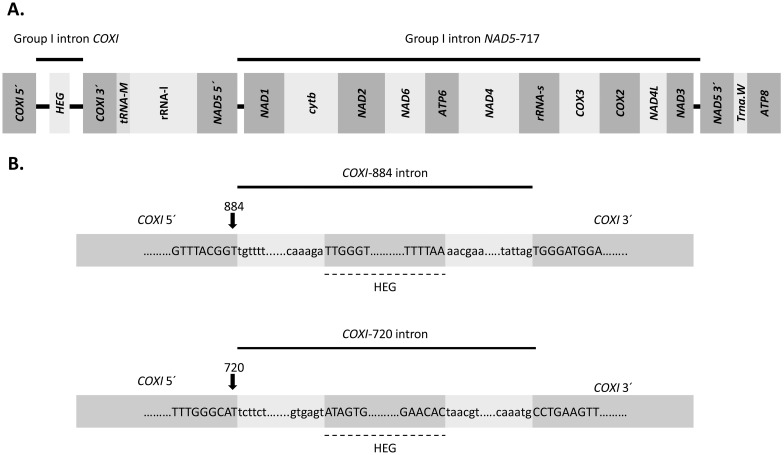
Mitochondrial gene content and schematic representation of group I intron and homing endonuclease genes found in Scleractinia.(A) Schematic map of the P. rus (complex Scleractinia) mitochondrial genome showing gene content and group I introns inserted in the COXI and NAD5 genes. The width of each box is proportional to gene size. (B) Representation of intron 884 (complex Scleractinia and Corallimorpharia) and intron 720 (robust Scleractinia) showing 5´and 3´ exons, and the putative homing endonuclease gene (HEG) of the LAGLIDADG family. The black arrows indicate intron insertion position in the COXI gene.